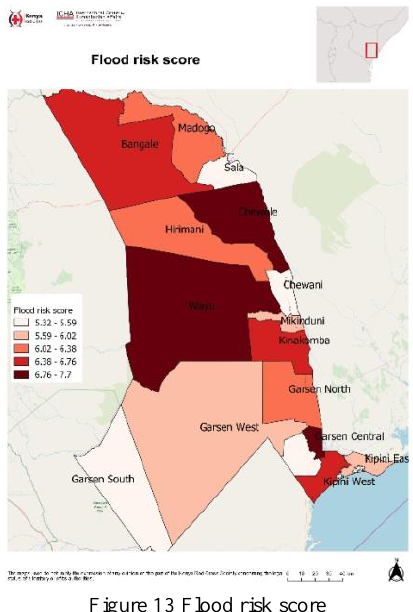
Figure 13 Flood risk